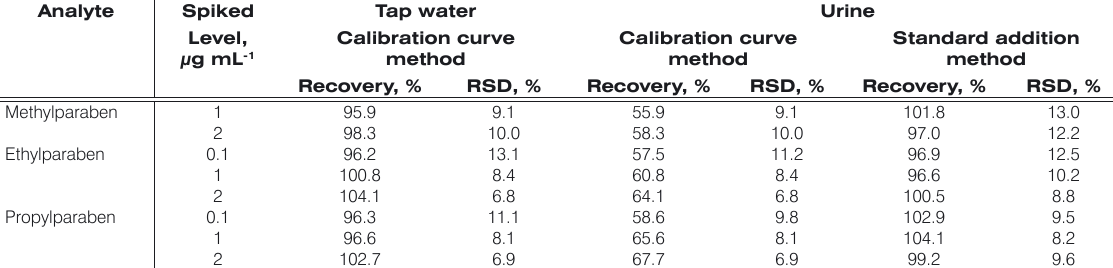
Table 2. Recoveries of spiked parabens in tap water and urine (n=5).